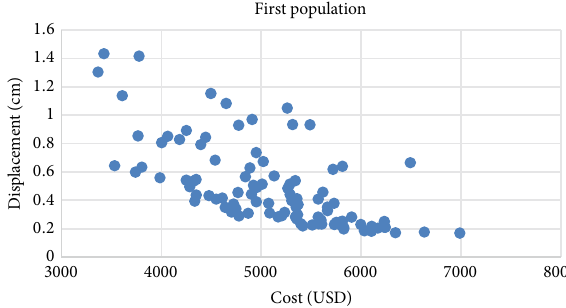
Fig. 3. The population diversity in the first model